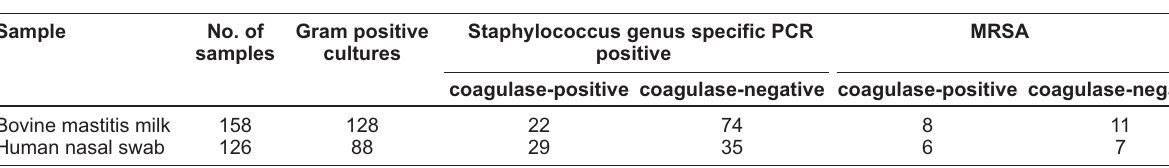
Table-1: Details of samples/isolates in this study Sample